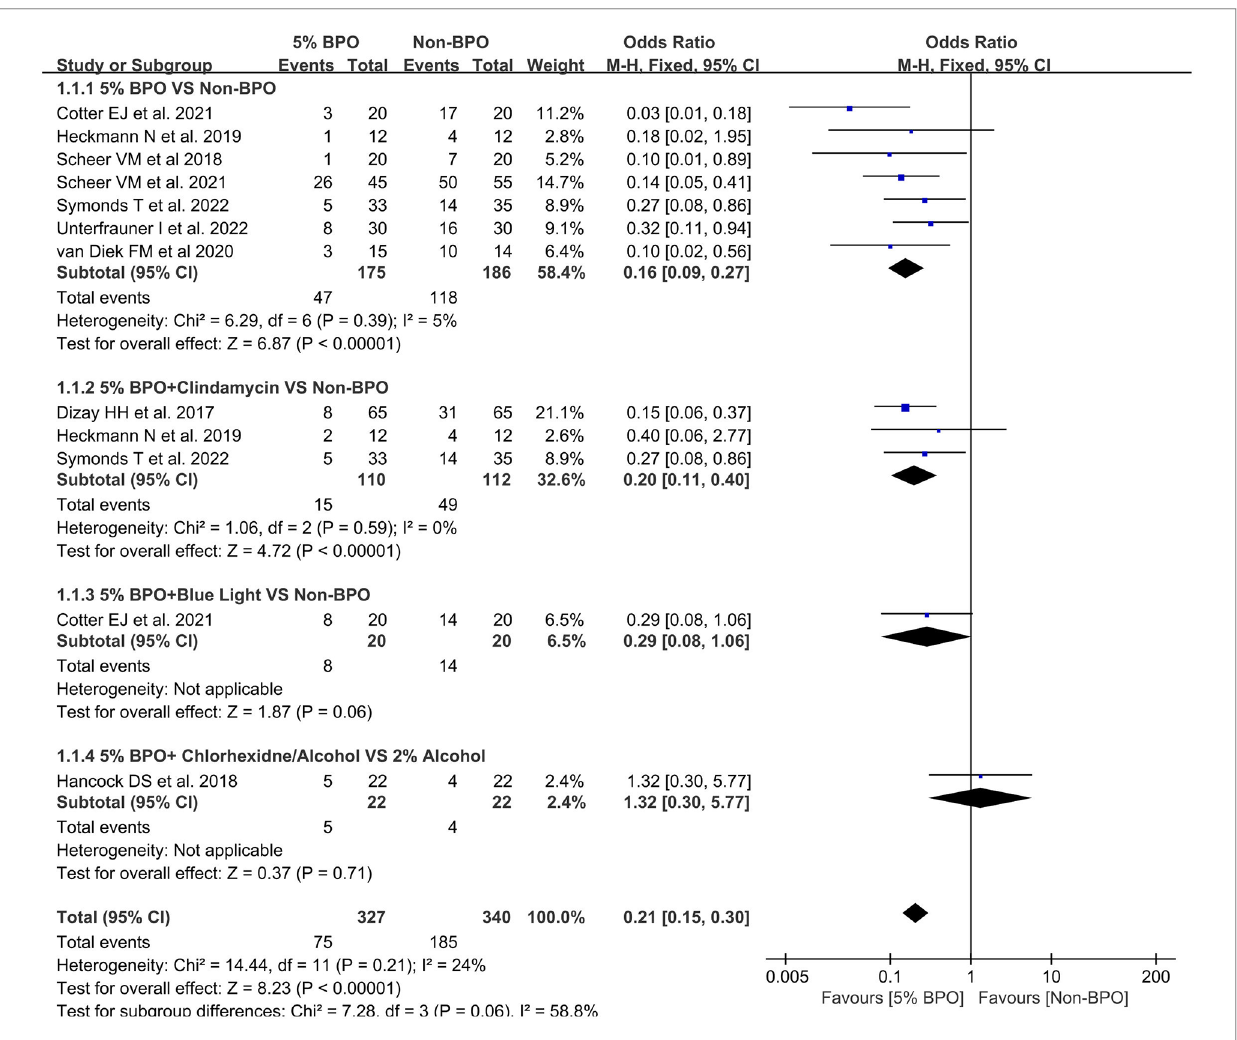
FIGURE 4 Forest plot showing the rate of positivity for Cutibacterium acnes in different 5% benzoyl peroxide groups vs. non- benzoyl peroxide groups.